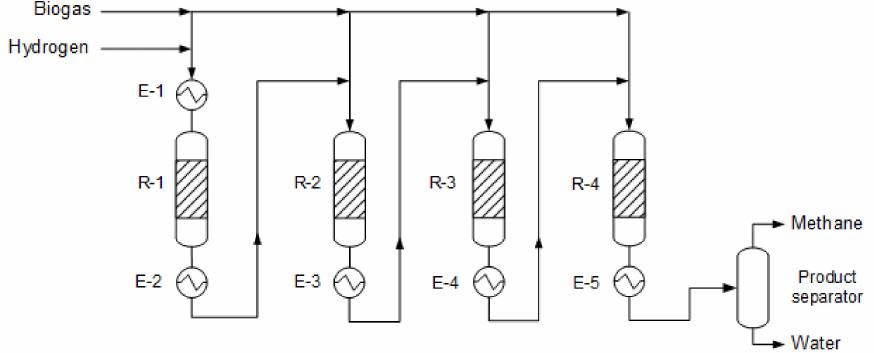
Figure 8. Reactor design of packed bed reactor (R-1, R-2, R-3, R-4), feed heater (E-1), and cooler (E-2, E-3, E-4, E-5) and product